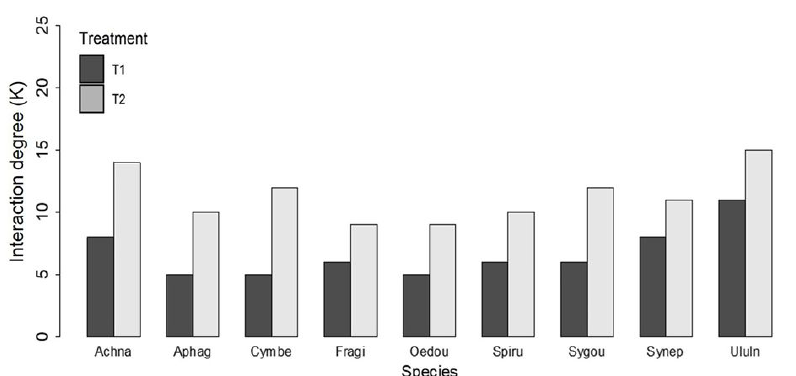
Figure 8. Interaction degree of periphytic algal species recorded in the treatment T1 (without zooplankton) and T2 (with zooplankton). Achna - Achnanthidium minutissimum ; Aphag - Aphanocapsa sp.1; Cymbe - Cymbella sp.1; Fragi - Fragilaria sp.1; Oedou - Oedogonium sp.1; Spiru - Spirogyra sp.1; Sygou - Synedra goulardii ; Synep - Synedra sp.1; Ululn - Ulnaria